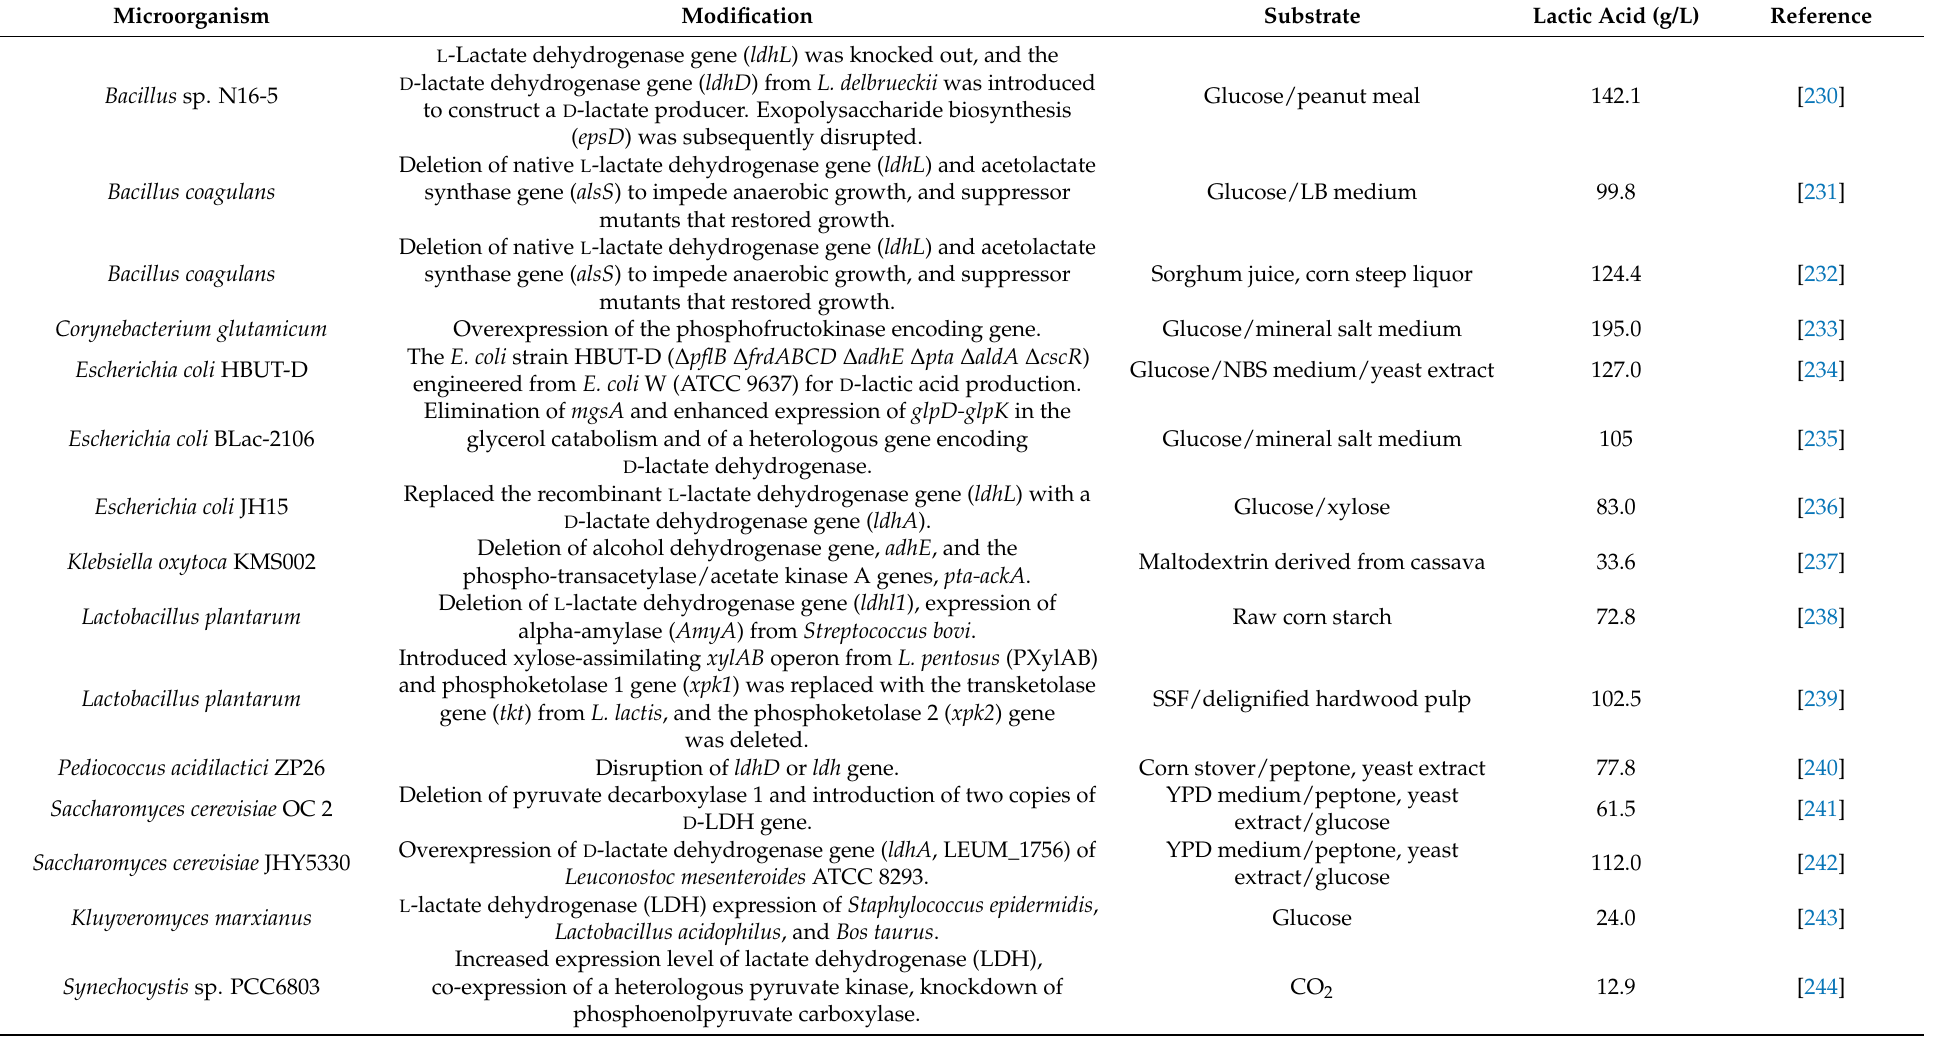
Table 4. Genetically modified microorganisms used for lactic acid